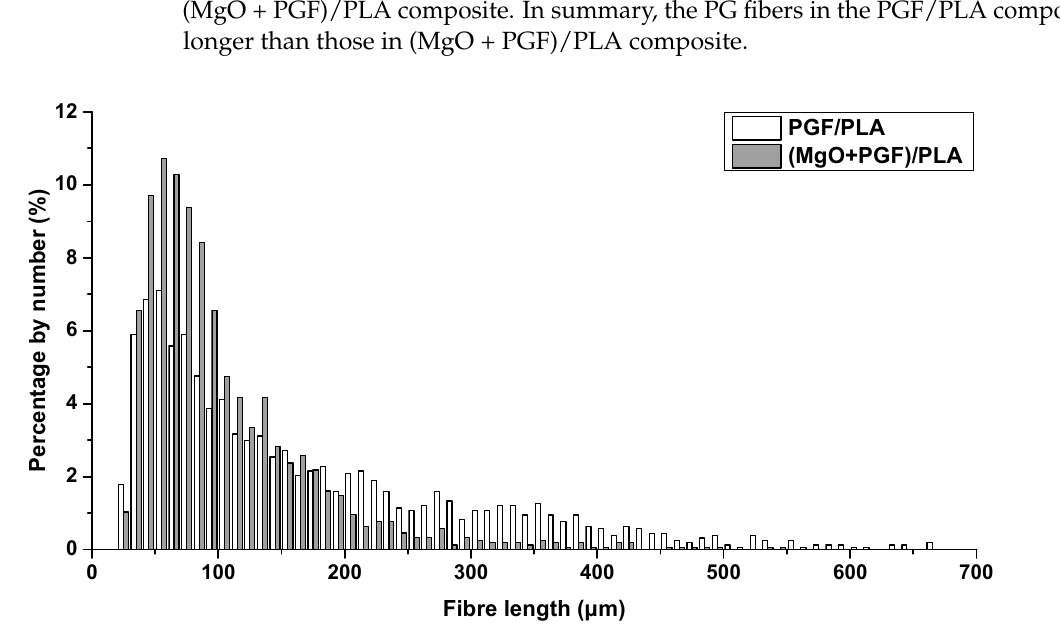
Figure 4. Distribution of the length of PGFs in PGF/PLA and (MgO + PGF)/PLA composite scaf.